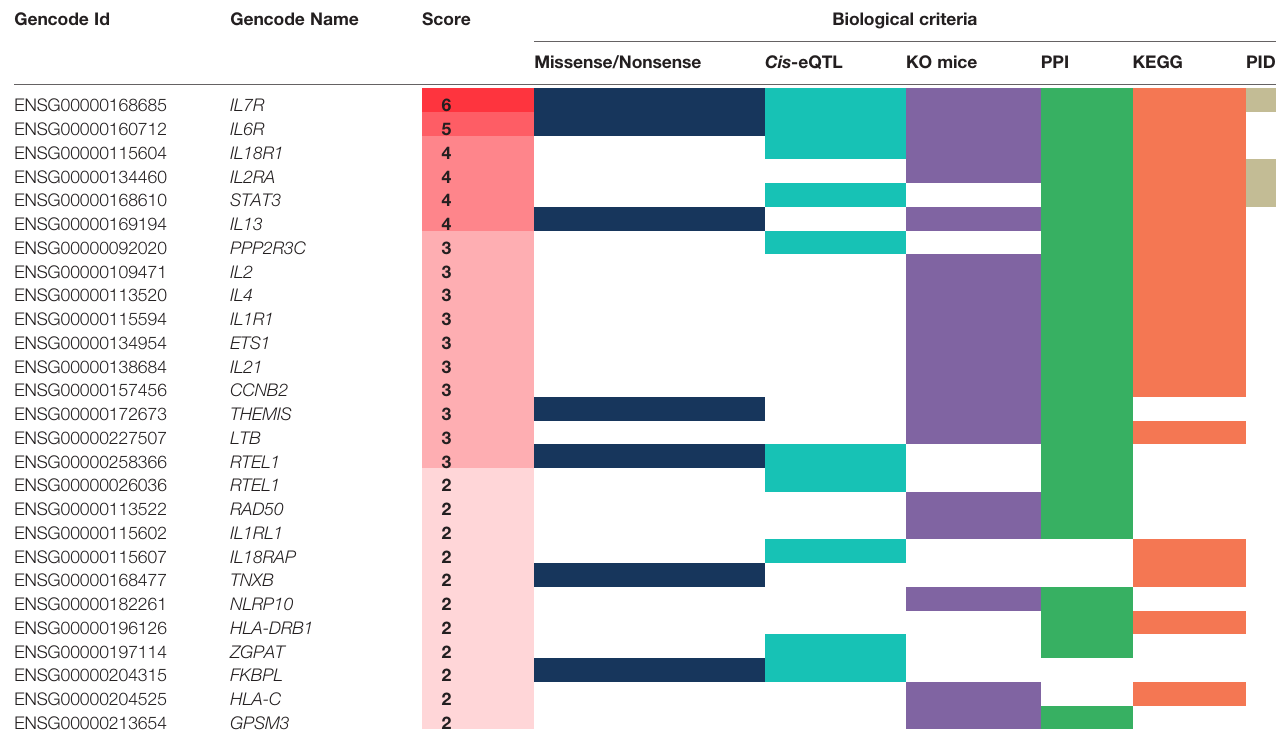
TABLE 1 | Biological atopic dermatitis risk genes.